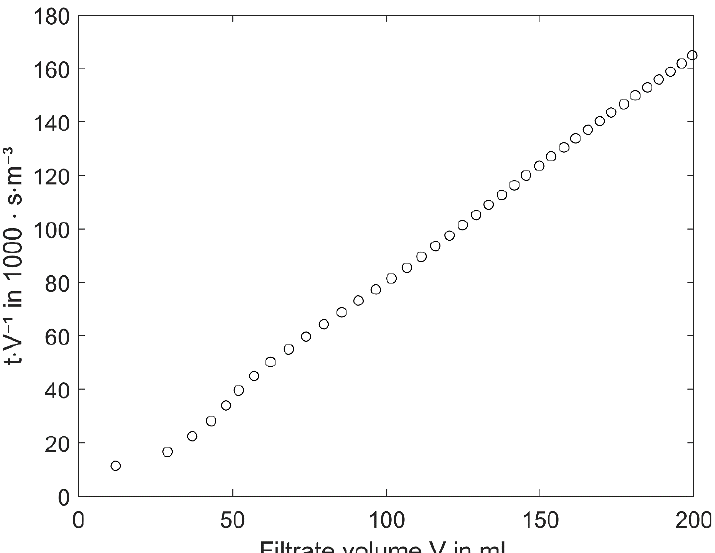
Figure 10. Typical filtration diagram obtained in the pressurized housing experiments with the filter medium (no spacer) and the filter cake formed from glass particles. medium (no spacer) and the filter cake formed from glass